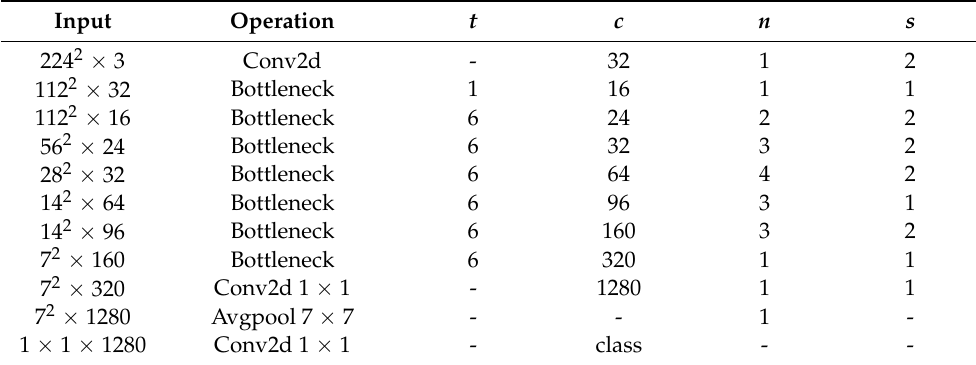
Table 1. MobileNetV2 network structure.